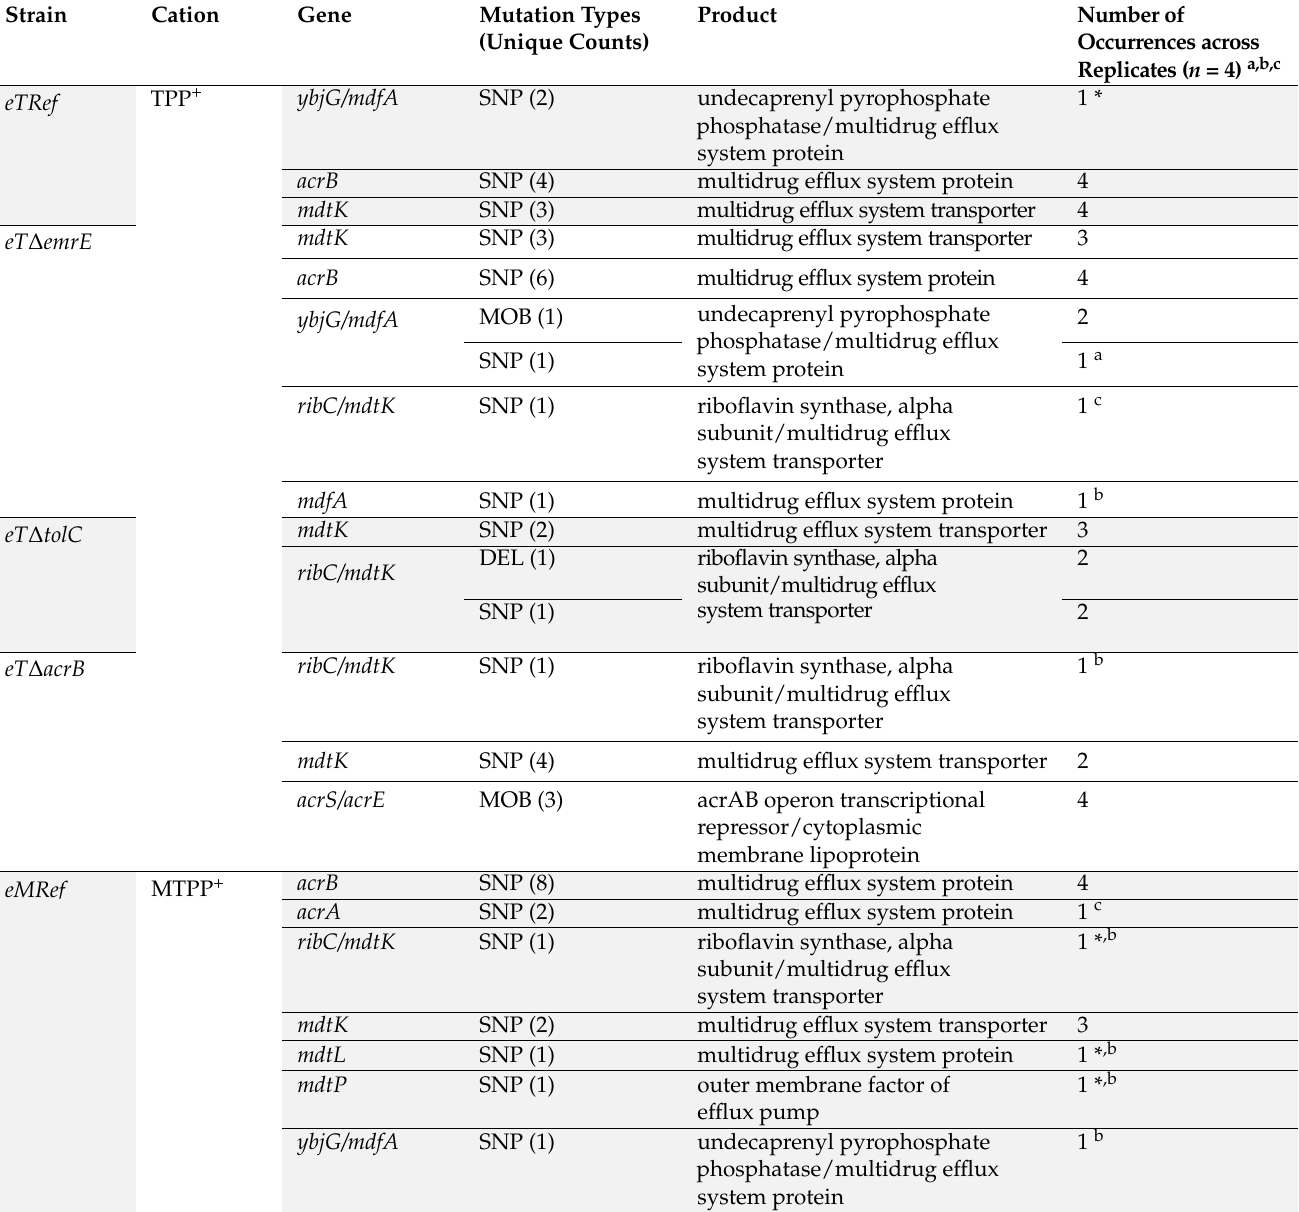
Table 1. Mutations that targeted unique ORFs or ORF intergenic regions identified for potential multidrug transporters (MDTs). Represented are the converged mutations that occurred in parallel evolution experiments ( n = 4). The number of occurrences represents the number of parallel replicates at which a given mutation occurred. Exceptions that are represented with number of occurrences = 1 are explained in the table